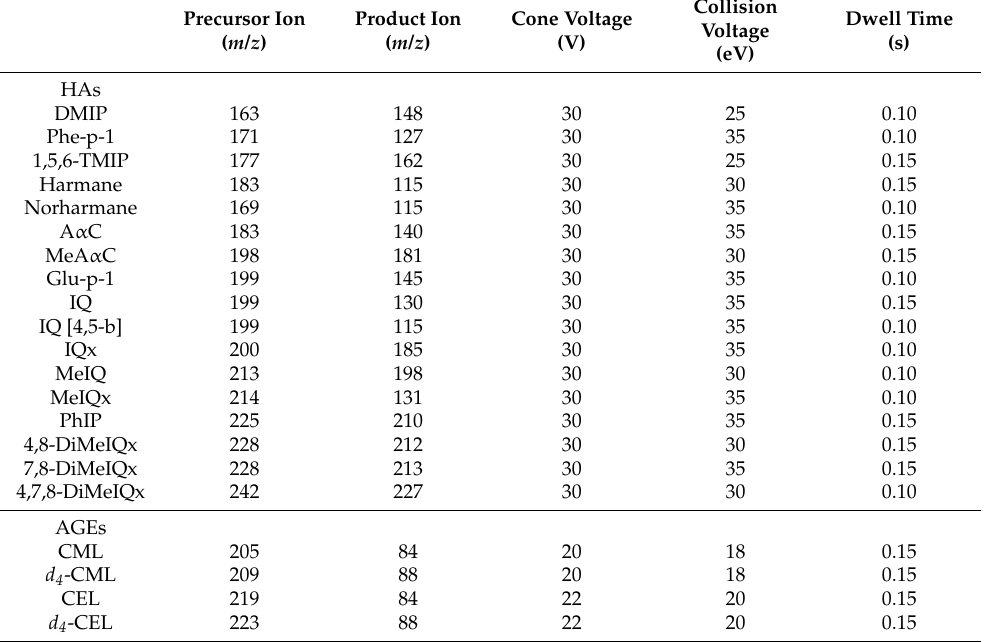
Table 2. Description of the MRM parameters for the analysis of HAs and AGEs in beef